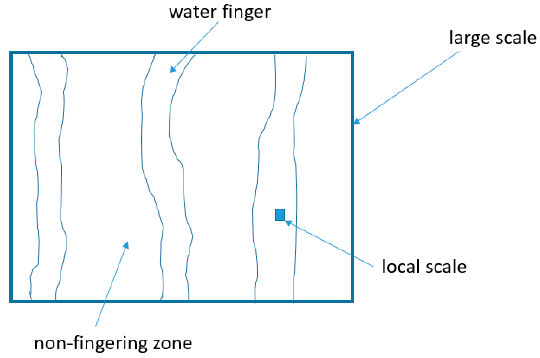
Figure 1. Two scales associated with fingering flow in porous media.